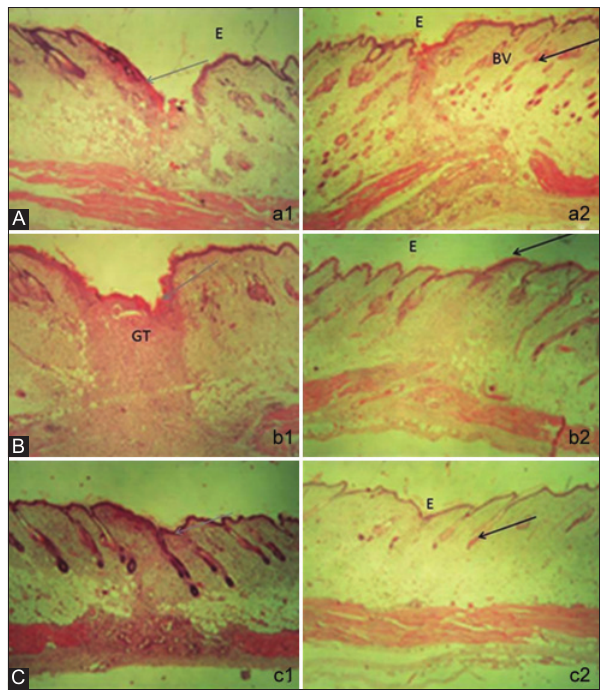
Figure-4: The histology of skin tissues at the 3 rd days of human umbilical mesenchymal stem cells conditioned medium (HU-MSCM) treatment stained with hematoxylin and eosin (H and E). (a2) Small number of inflammatory cells and abundance of blood vessels (black arrow) in compared with the control which still have abundance inflammatory cells (gray arrow) (a1) (magnification 20×) E: Epidermis, BV: Blood vessels. (b) The histology of skin tissues at the 6 th days of human umbilical mesenchymal stem cells conditioned medium treatment stained with hematoxylin and eosin (b2), Decreasing inflammatory cells followed by increasing re-epithelization and more density of collagen fiber (black arrow), (b1) sample from the control, a lot of inflammatory cells are found (gray arrow) (magnification 20×) E: Epidermis, GT: Granulation tissues. (c) The histology of skin tissues at the 9 th day of human umbilical mesenchymal stem cells conditioned medium treatment stained with hematoxylin and eosin. Fibroblasts are increasing and hair follicles created, the muscles regenerations is clearly appeared (black arrow) (c2), however, on the povidone-iodine treatment, infiltration of inflammation cells are still increasing (gray arrow) (c1) (magnification 20×). E: